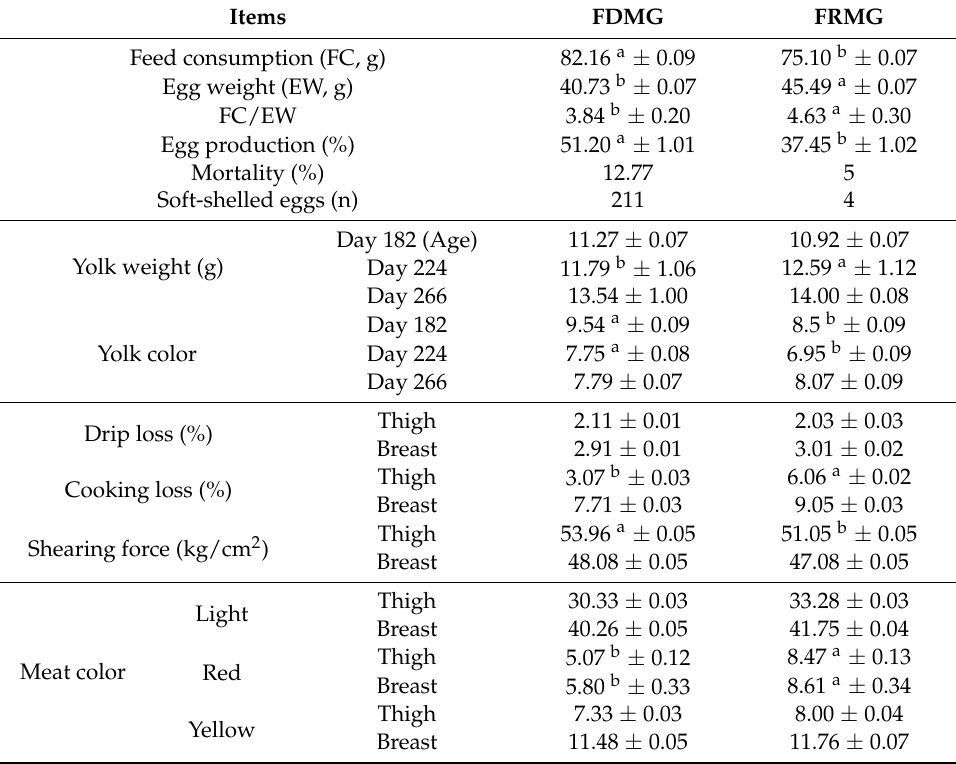
Table 3. Production performance ( n = 100), egg production and quality ( n = 30) and meat quality ( n = 10) between cage rearing (FDMG) and free-range rearing system